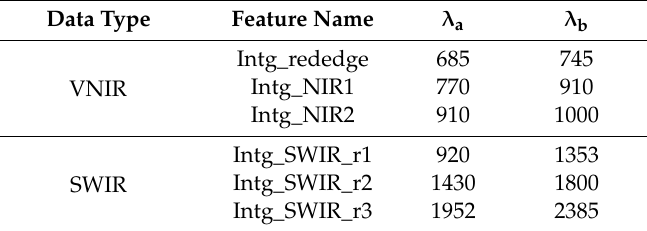
Table A4. Integration features extracted from each HSI spectrum.